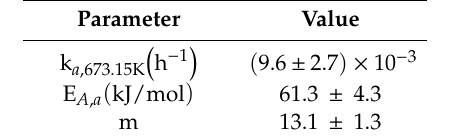
Table 7. Aging kinetics parameters.